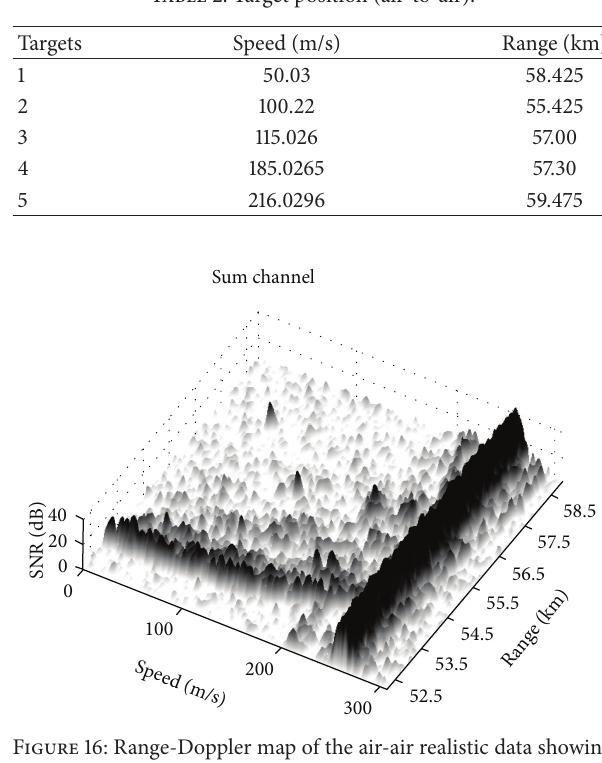
Figure 16: Range-Doppler map of the air-air realistic data showing the sum channel.